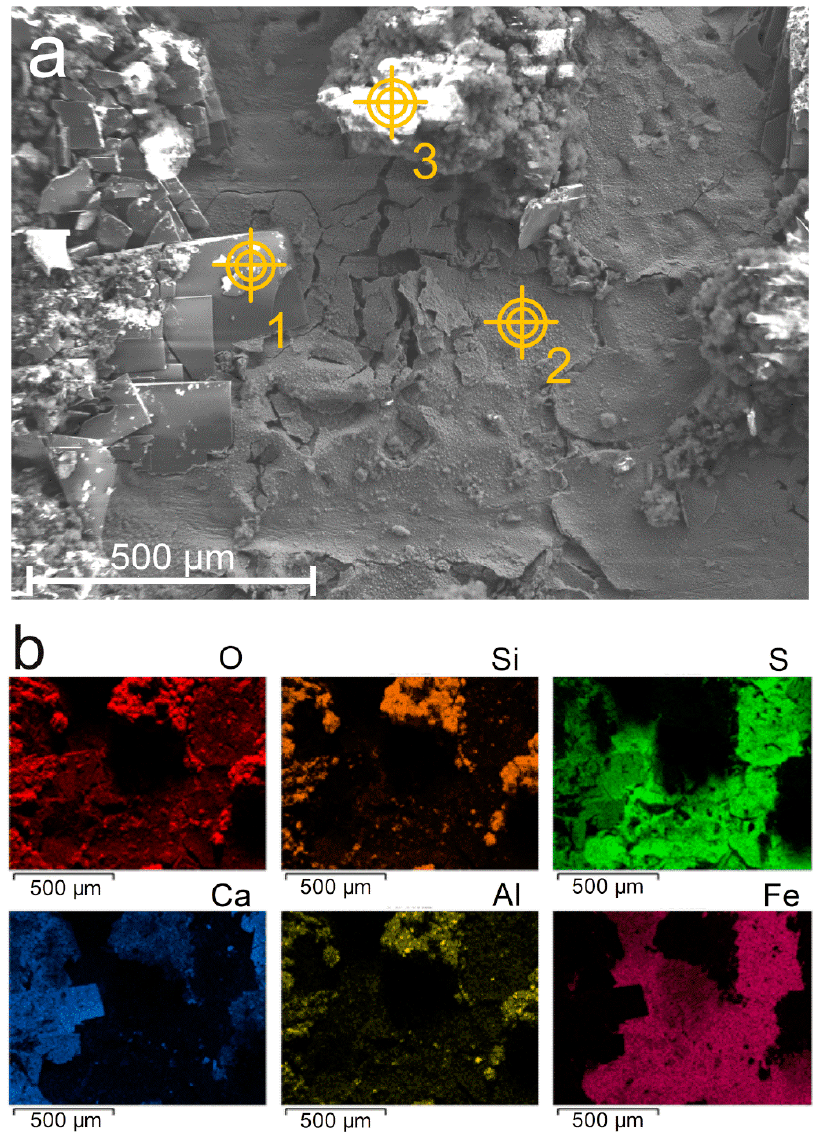
Figure 6. SEM analysis of the surface of the layer covering a carbon steel surface after the experiment. ( a ) SEM image (secondary electrons) of the layer covering the carbon steel surface with 3 spots indicating where quantitative EDS analysis was performed; ( b ) corresponding EDS maps.